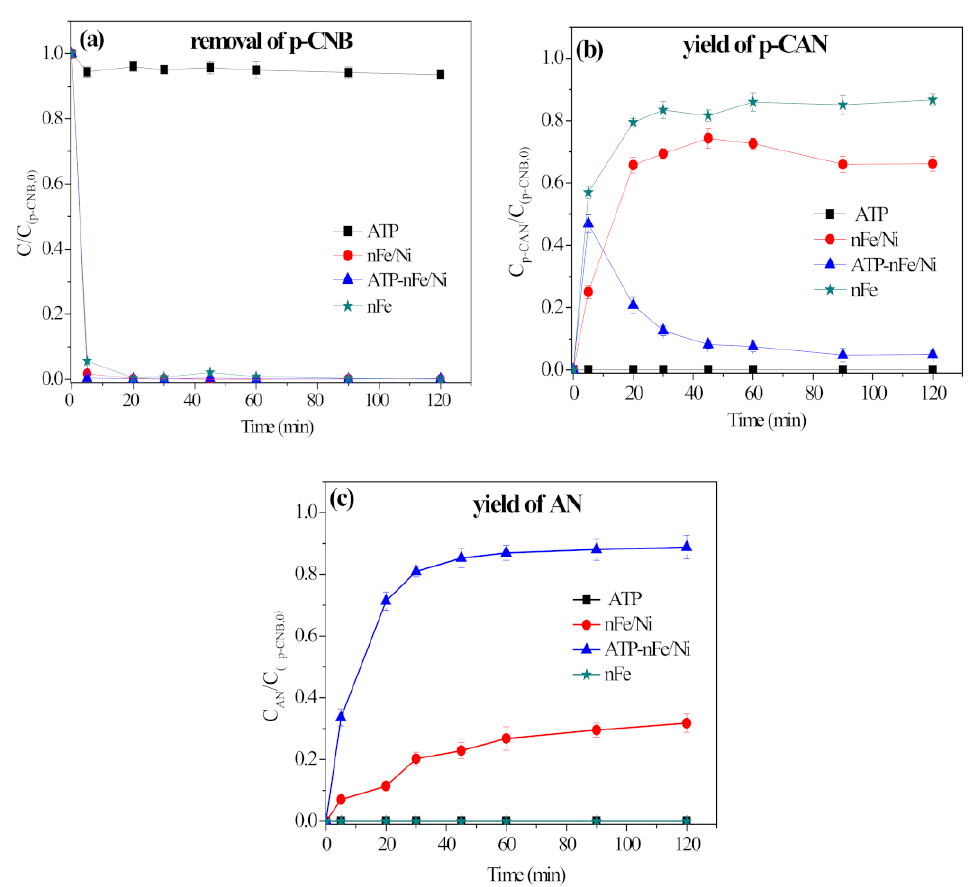
Figure 4. Removal of p-CNB ( a ), nitroreduction of p-CNB (yield of p-CAN) ( b ) and dechlorination of p-CNB (yield of AN) ( c ) by different materials (reaction conditions: concentration of p-CNB = 10 mg/L, dosage of material = 0.5 g/L and initial pH = 5.6 ±